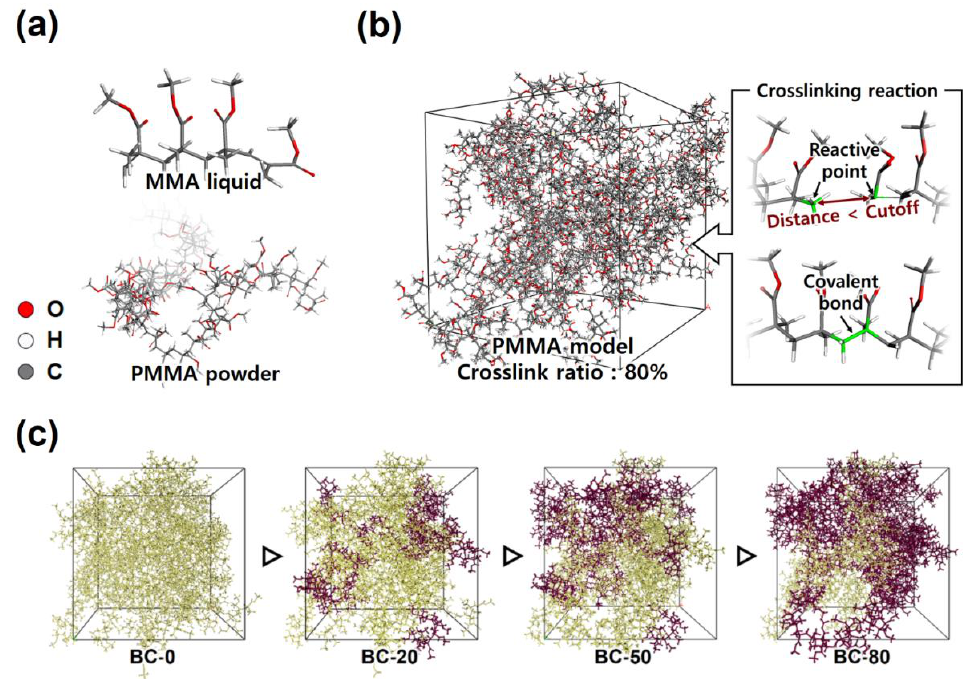
Figure 1. The all-atom BC model used in this study. ( a ) Molecular structures of the MMA liquid and the PMMA powder, and ( b ) a configuration of the BC unit cell with the crosslinking ratio of 80%. ( c ) Snapshots of the PMMA-based BC as the crosslinking reaction proceeds. The constituent molecules participated in the reaction are highlighted in reddish